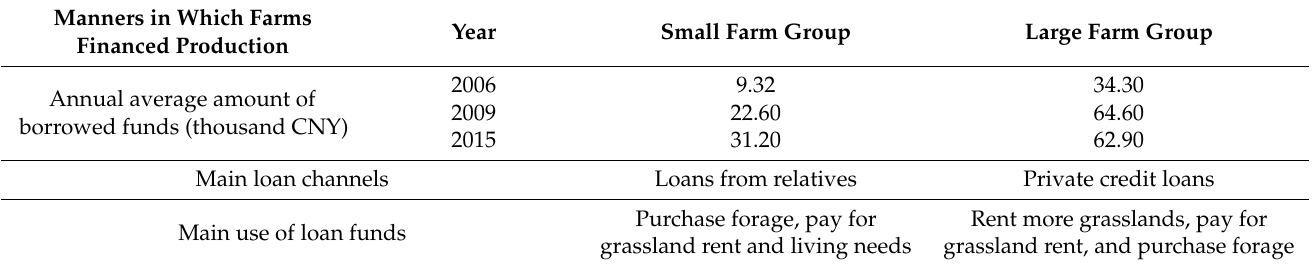
Table 1. Manners in which farms financed production for small and large farm